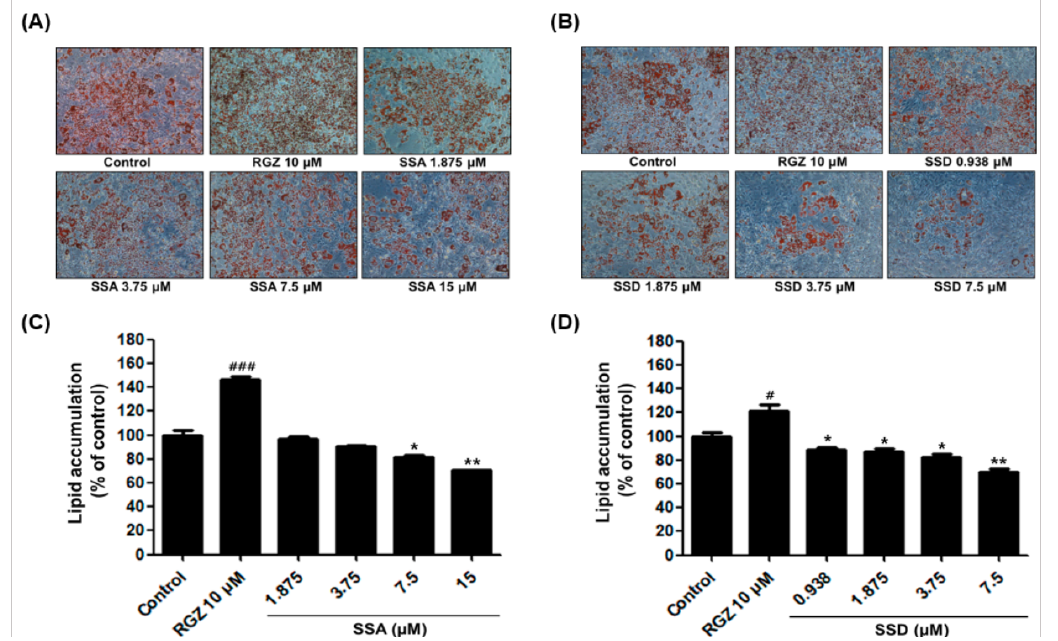
Figure 2. Effect of SSA and SSD on lipid accumulation in 3T3-L1 cells. ( A , B ) Representative cell images were captured at 100 × magnification. ( C , D ) The lipid droplets were stained Oil Red O solution and extracted using isopropanol. Then, they were quantified using a microplate reader at the wavelength of 520 nm. Data are presented as a percentage of control (0.5% DMSO) and RGZ (rosiglitazone) was used as a positive control for this experiment. Results are mean ± standard error of the mean (SEM, n = 3); * p < 0.05, ** p < 0.01, # p < 0.05, ### p < 0.001, compared with control. #: increased compared to control, *: decreased compared to